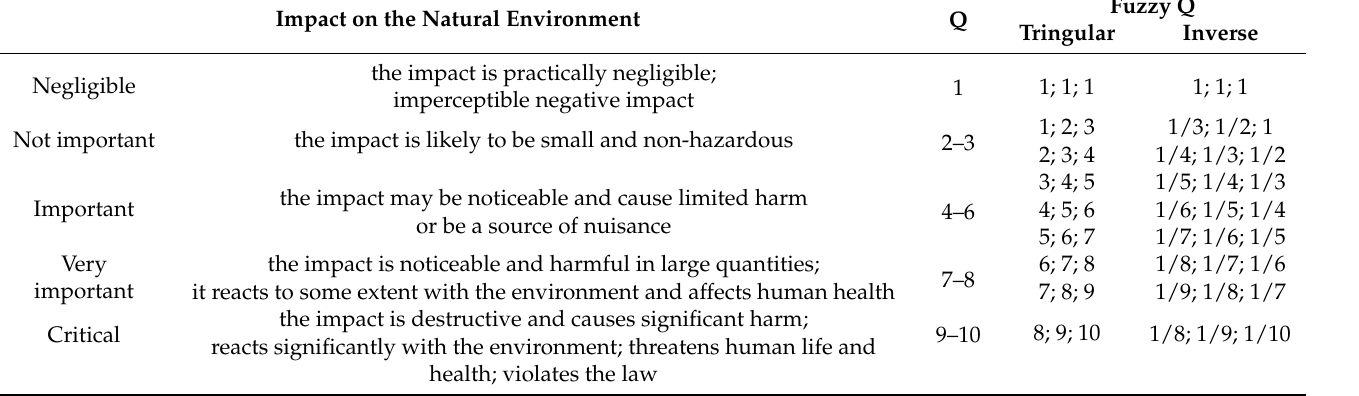
Table 4. Characteristic of assumed priority number E—impact on the natural environment caused by process or product. Own study.